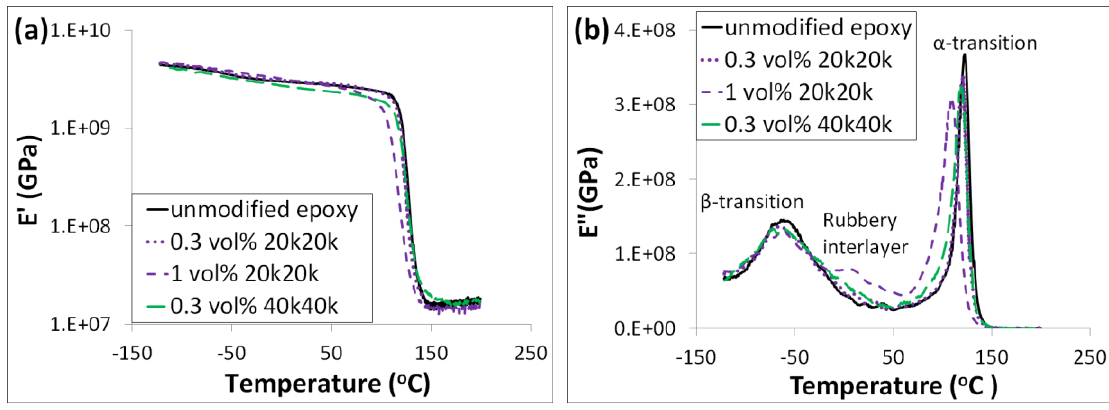
Figure 7. A temperature sweep of the neat epoxy and PHMA-b-PGMA grafted SiO